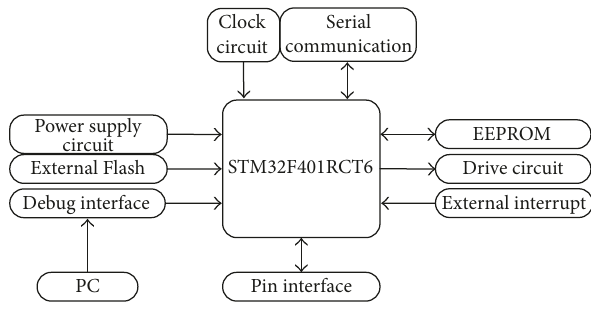
Figure 3: Structure of the main control